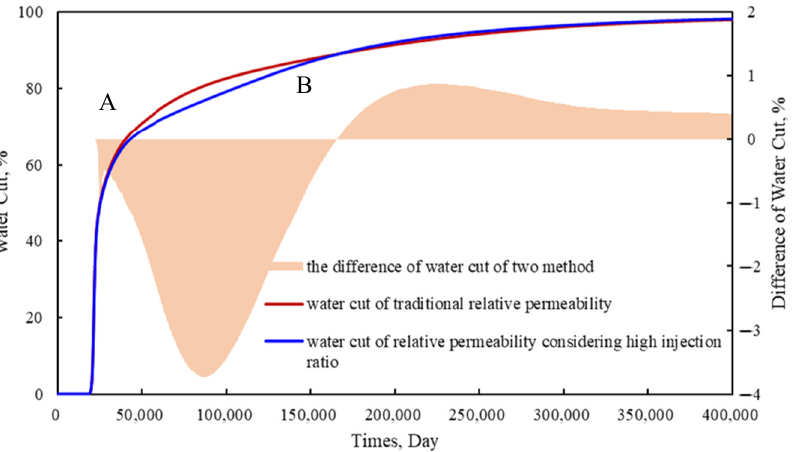
Figure 12. The water cut curve of numerical simulation of traditional simulator and simulator that considering high water waterflooding PVs.